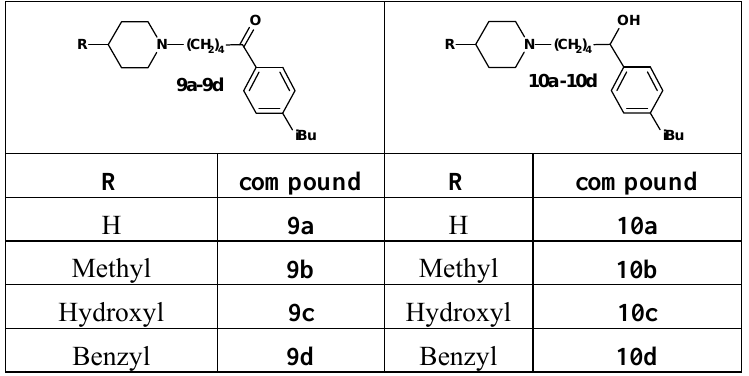
Table 3. Synthesized terfenadine derivatives 9a-9d and 10a - 10d